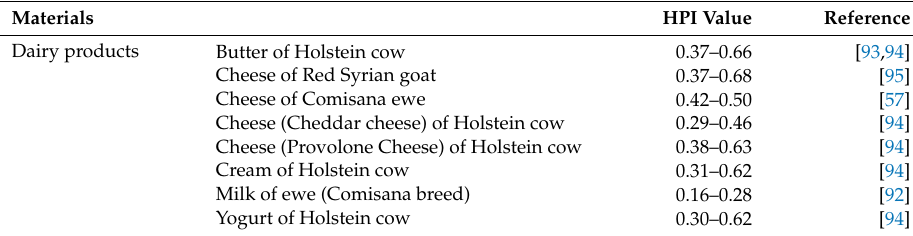
Table 6. Application of HPI in fatty acid evaluation